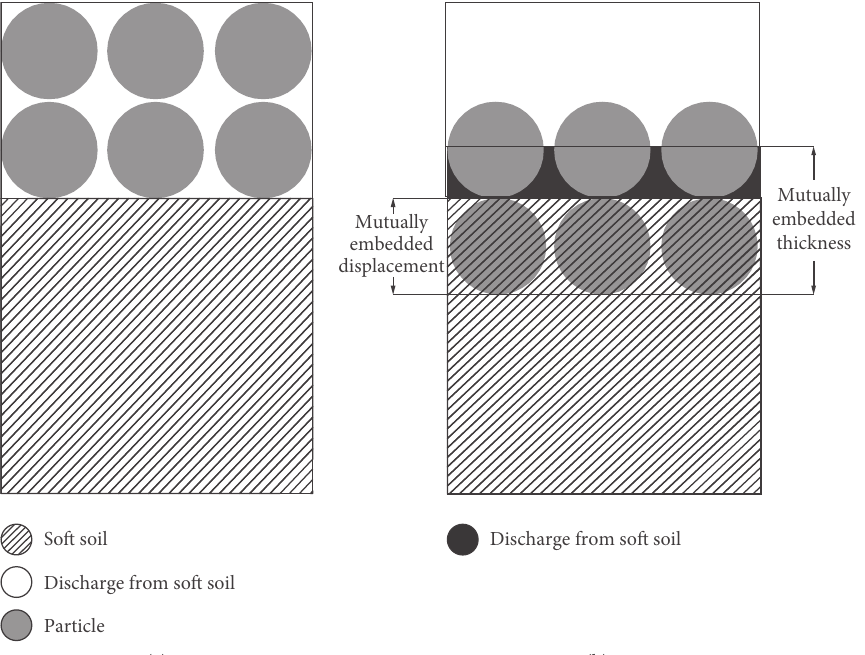
Figure 1: An example of mutual embedding of soft soil and miscellaneous fill particles: (a) before mutual embedding; (b) after mutual